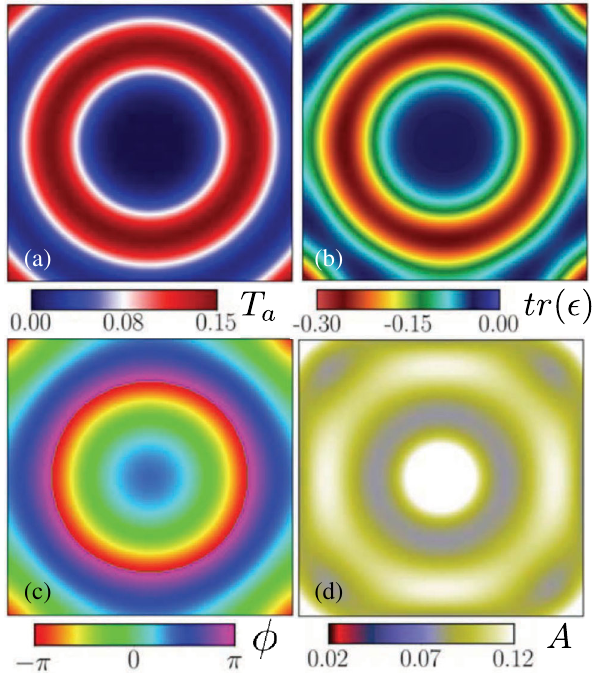
FIG. 2. A clockwise rotating spiral of active contraction and FIG. 3. Focal active contraction and strain pattern in a 2D strain in a 2D isotropic elastic tissue. (a) Analytically derived isotropic elastic tissue. (a) Circular ring-shaped focal pattern of x; y Þ . (b) The corresponding strain active contraction field T a ð x; y Þ . (b) The corresponding strain field active contraction T field Tr ð ϵ Þð x; y Þ is isotropic and closely follows the contraction a ð Tr ð ϵ Þð x; y Þ is isotropic and closely follows the circular active field. (c) The mechanical phase map ϕ ð ϵ Þð x; y Þ reveals a contraction field. (c) The mechanical phase map ϕ ð ϵ Þð x; y Þ mechanical phase singularity at the center of the rotor (red exhibits a focal pattern and does not exhibit a phase singularity circle). (d) The complex amplitude A ð x; y Þ vanishes at the at any point. (d) The complex amplitude A ð x; y Þ does not vanish position of the mechanical phase singularity. at any